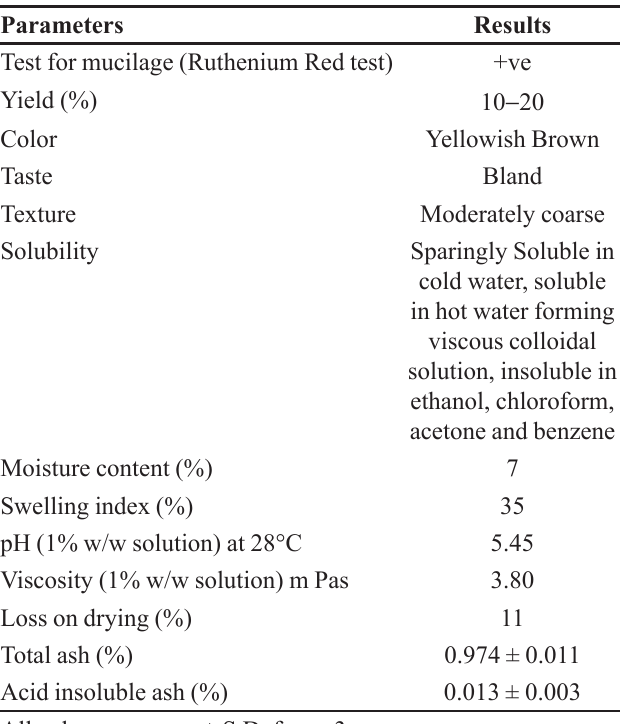
TABLE II - Organoleptic properties of Mulva neglecta mucilage